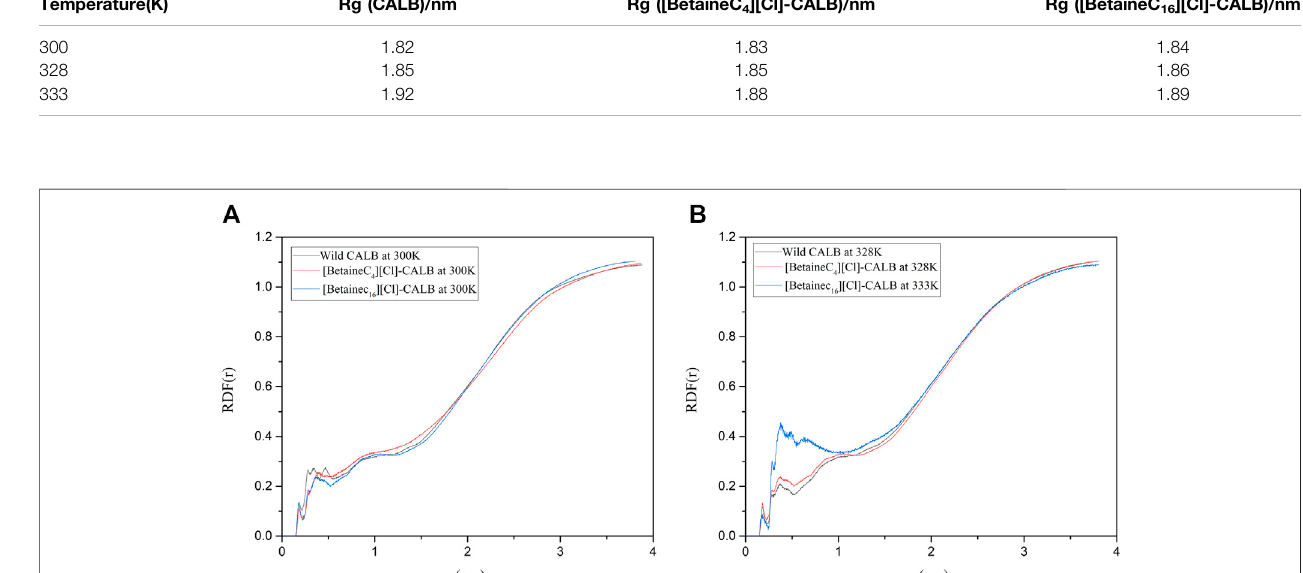
FIGURE 11 | Radial distribution of water molecules around the active center of the native and modi fi ed enzymes at their respective optimal temperatures.